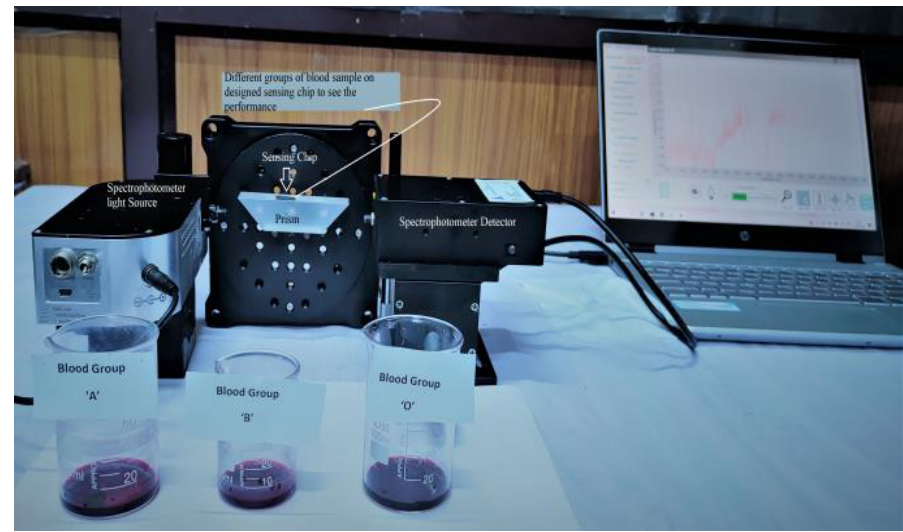
Figure 7. Prism based experimental set-up for blood group identification integrated with photo spectrometer.